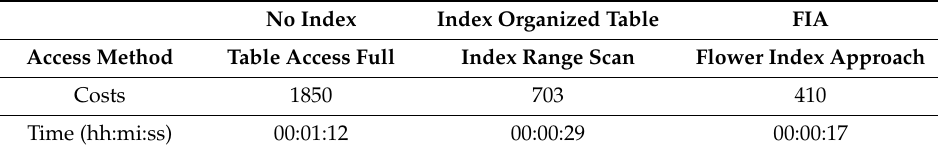
Table 4. Index processing—costs and time demand—index